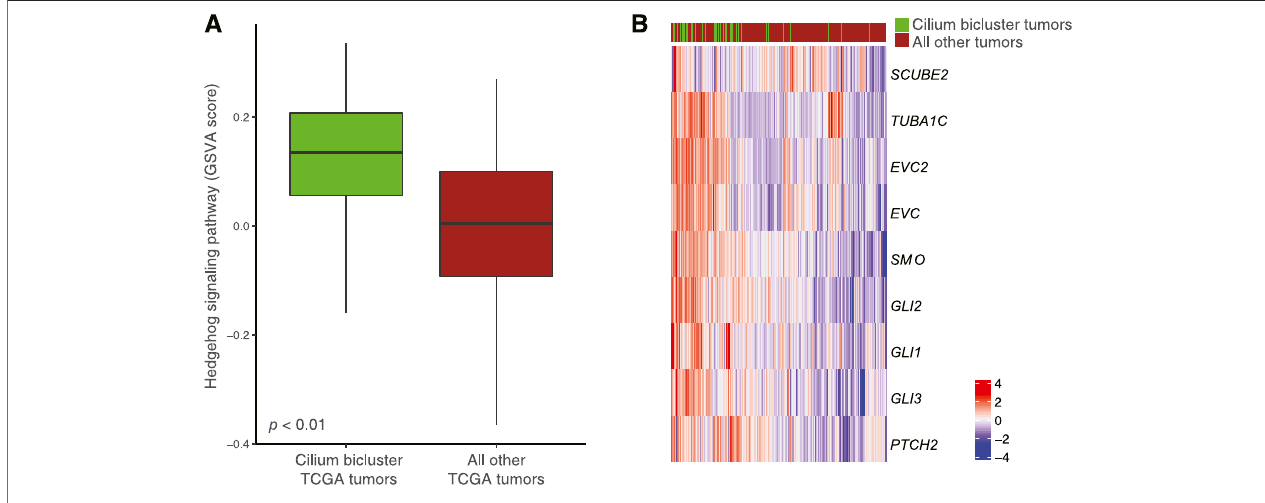
FIGURE 7 | (A) Upregulation of the Hedgehog signaling pathway in TCGA tumors with cilium-associated expression based on the GSVA scores. (B) Differential expression of Hedgehog signaling genes in the cilium bicluster tumors vs. all other tumors.